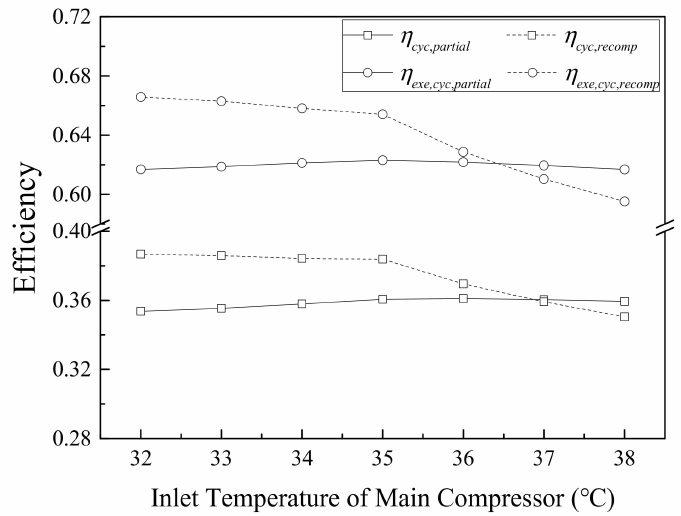
Figure 8. Effects of T min on η cyc and η exe , cyc with the partial-cooling cycle compared with the recom- pression cycle.